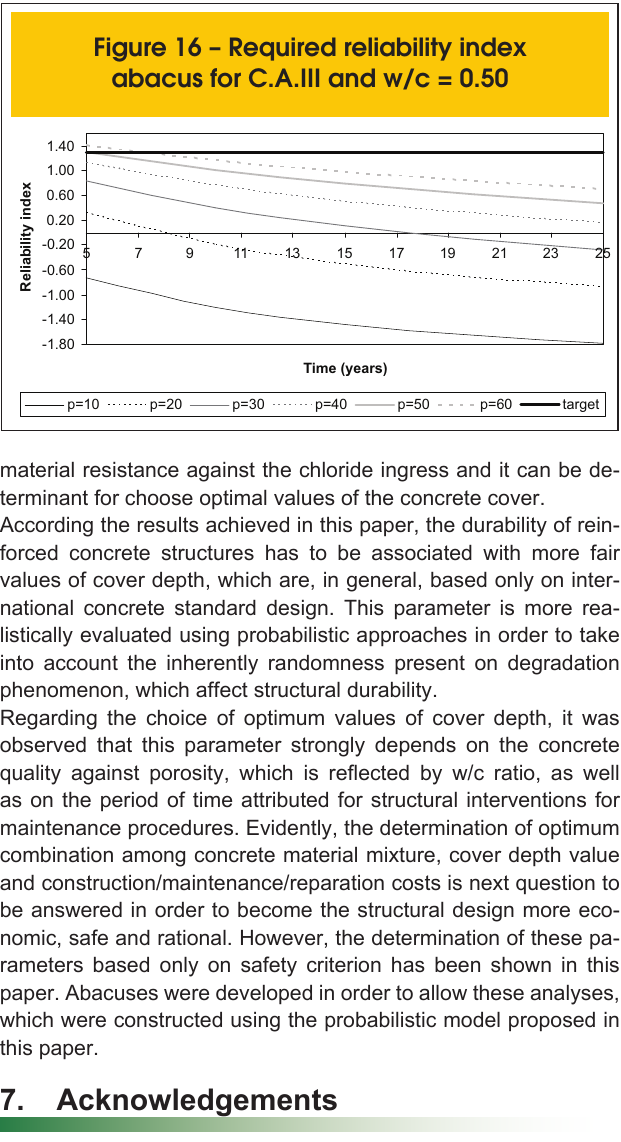
Figure 16 – Required reliability index abacus for C.A.III and w/c =